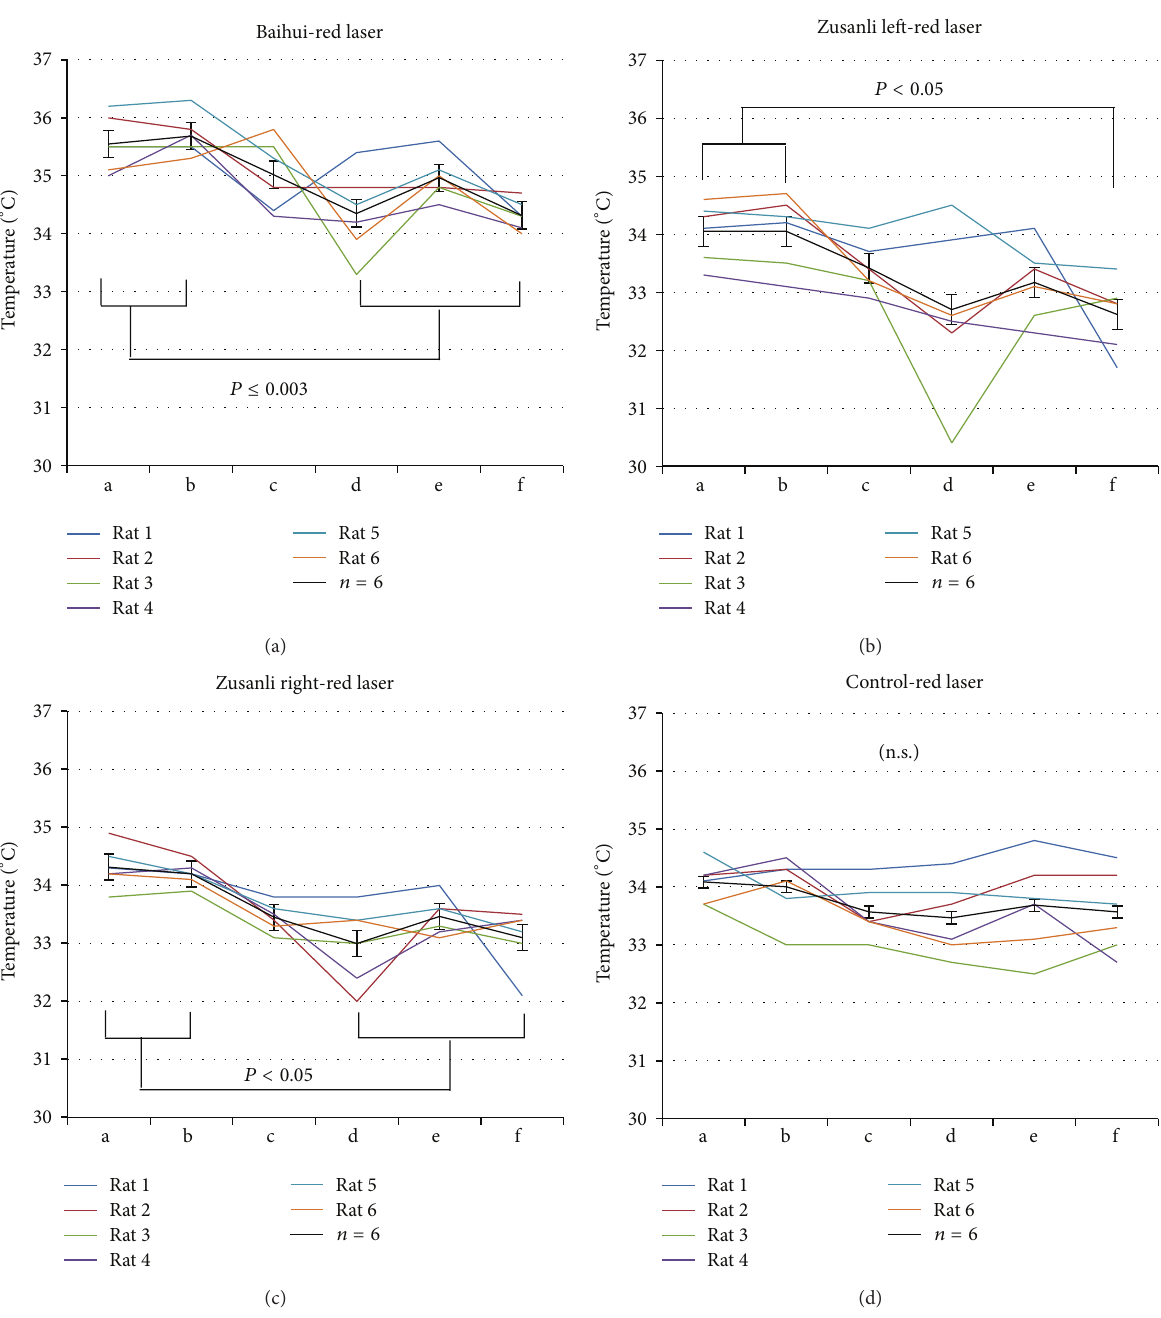
Figure 8: Temperature values of all rats during the different phases (a–f, see Figure 4) of red laser stimulation. Significant changes were found for all acupoints, but not for the control